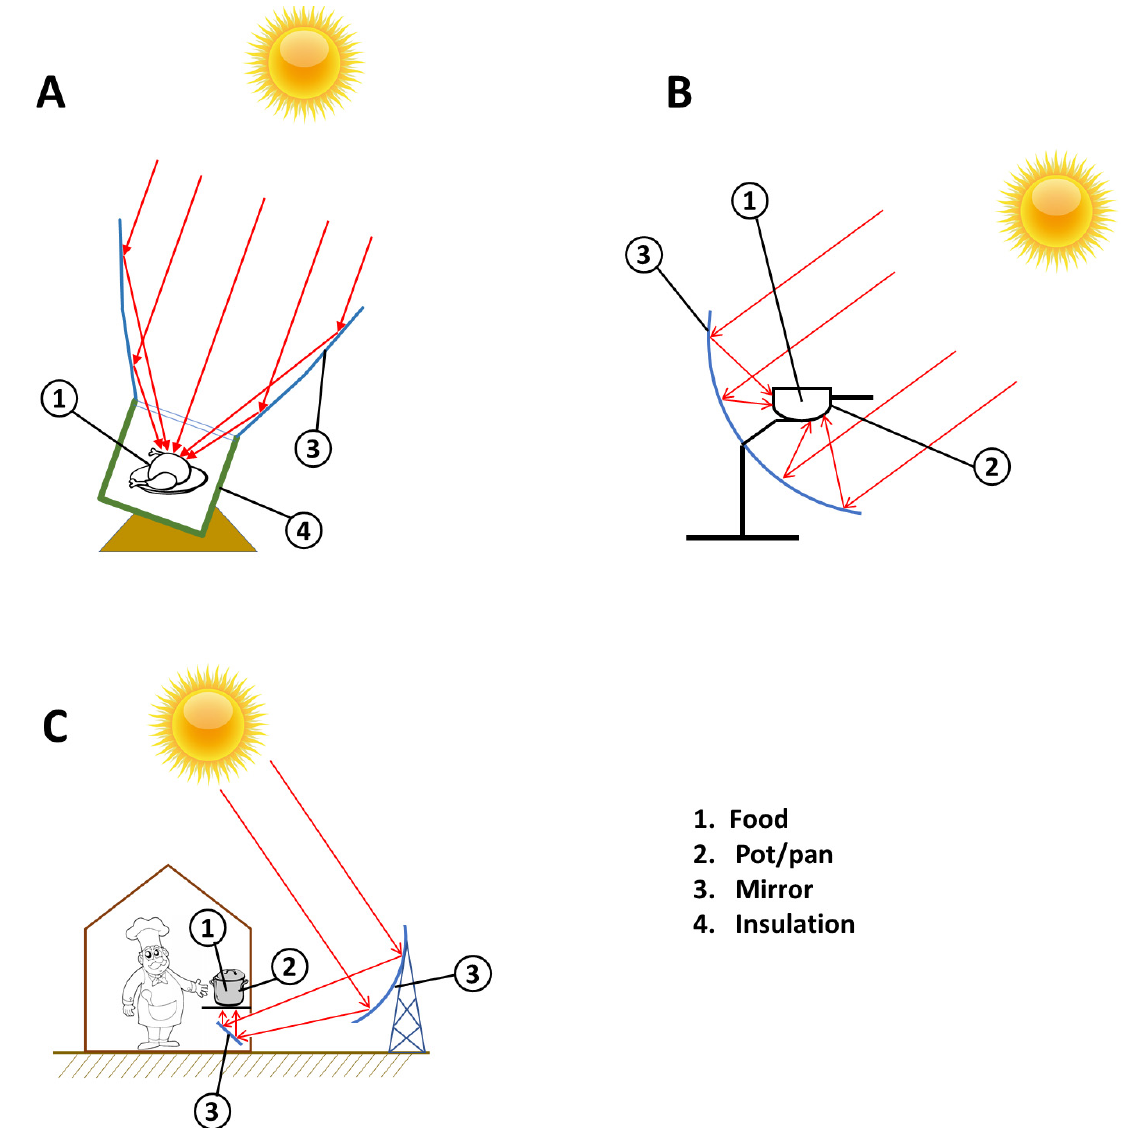
Figure 3. Sketched structures of Solar cookers (SCs) with direct cooking method. ( A ) SC with sunlight concentrated into the food; ( B ) SC with the focus of a parabolic sunlight absorber under the pot; ( C ) SC with a parabolic sunlight absorber that concentrates the heat under the stovetop by a system of reflecting mirrors.